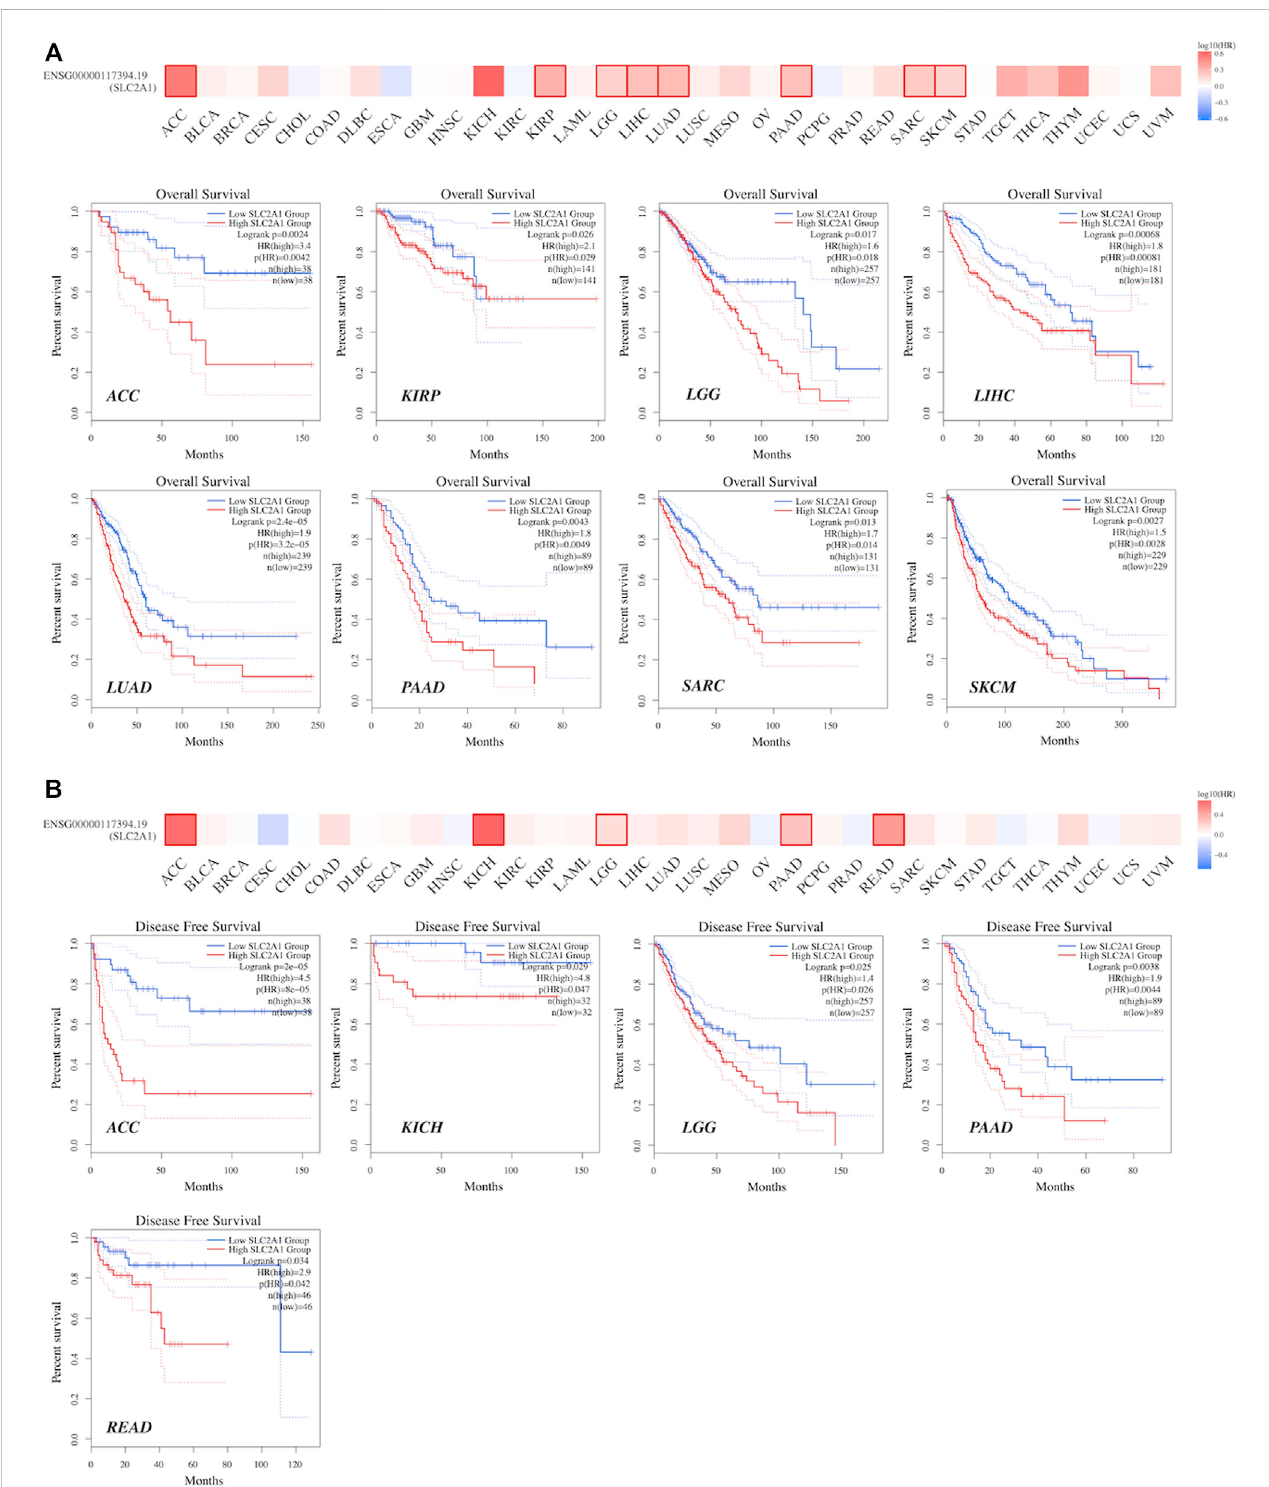
FIGURE 6 The prognostic values of SLC2A1, including OS and DFS, were evaluated across TCGA cancers in GEPIA2 (A) The expression of SLC2A1 was associated with OS in patients with ACC, KIRP, LGG, LIHC, LUAD, PAAD, SARC and SKCM (B) The expression of SLC2A1 was associated with DFS in patients with ACC, KICH, LGG, PAAD and READ. The cutoff value was set as follows: p -value < 0.05 and |logFC| >